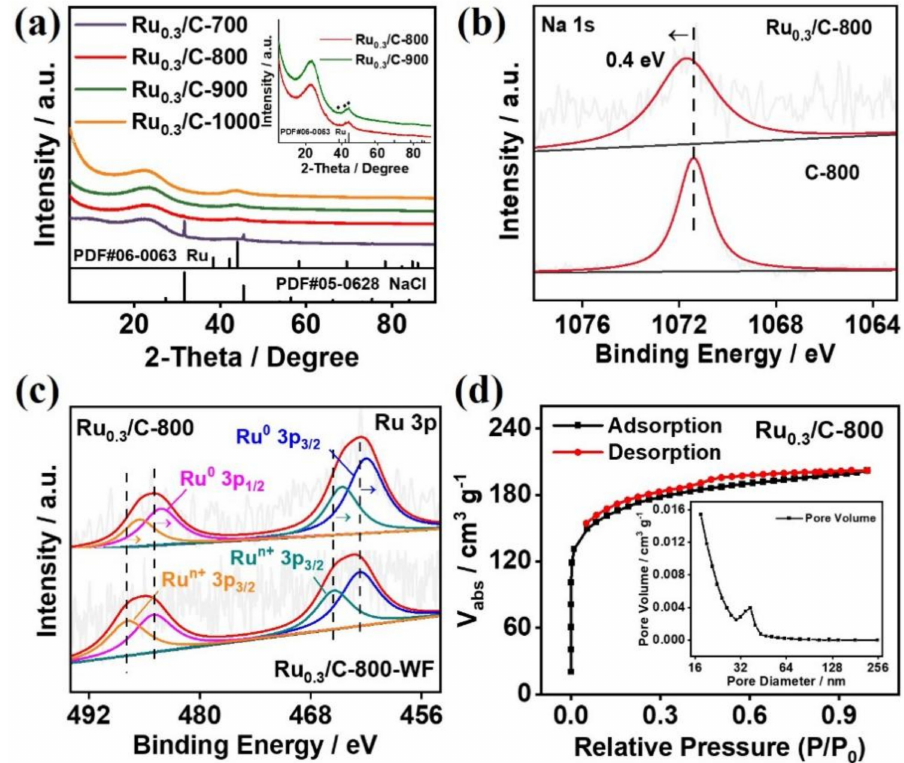
Figure 3. ( a ) XRD patterns of Ru 0.3 /C − 700, Ru 0.3 /C − 800, Ru 0.3 /C − 900. and Ru 0.3 /C − 1000; ( b ) XPS spectra of Na 1s of Ru 0.3 /C − 800 and C − 800; ( c ) XPS spectra of Ru 3p of Ru 0.3 /C − 800 and Ru 0.3 /C − 800 − WF; ( d ) N 2 adsorption/desorption curves of Ru 0.3 /C − 800 (inset: pore size distribution